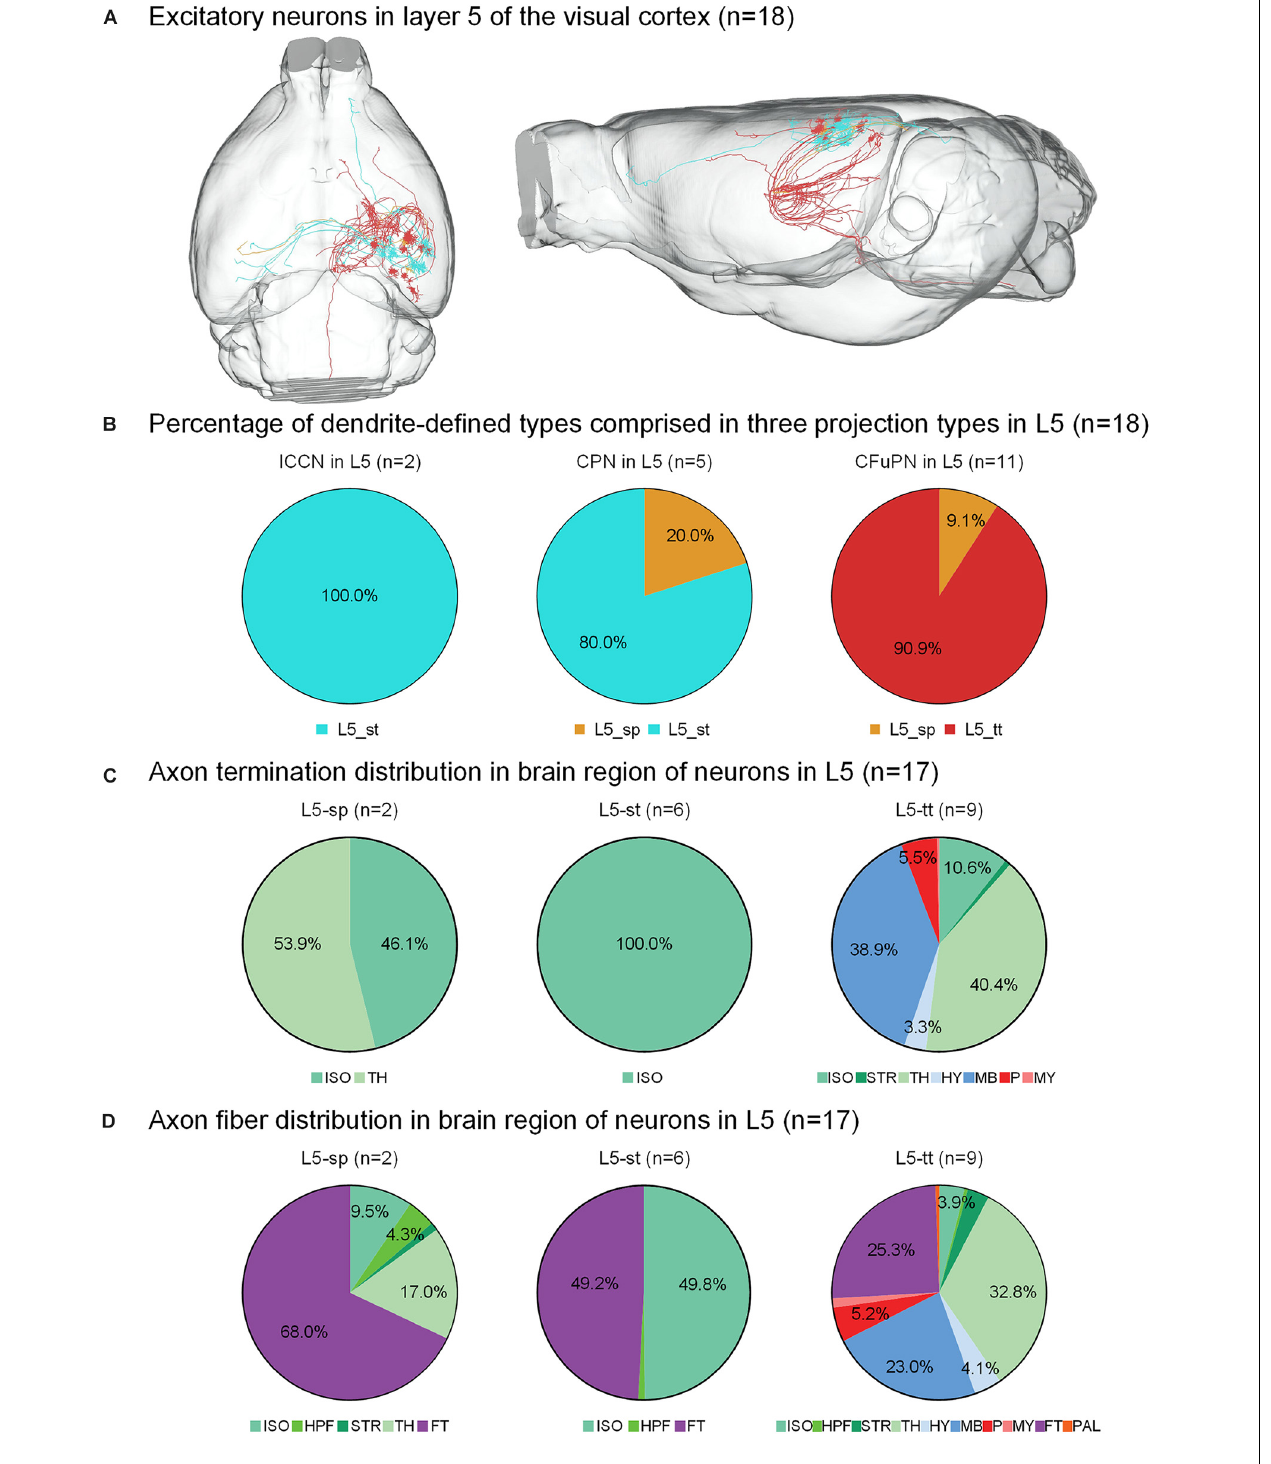
FIGURE 3 | Axonal classification and projection patterns of 18 excitatory neurons in layer 5. (A) The 18 neurons in L5 with their complete morphologies are shown in the mouse brain. (B) The percentage of dendrite-defined types comprises the ipsilateral circuit connection neurons (ICCNs), the callosal projection neurons (CPNs) and the corticofugal projection neurons (CFuPNs) in L5. (C) The pie charts show the regional distribution of axonal terminals for different neuronal types in L5. (D) The pie charts show the percentage distribution of axonal length in different brain regions for the L5 neurons. For brain regions: isocortex (ISO), hippocampal formation (HPF), striatum (STR), thalamus (TH), hypothalamus (HY), midbrain (MB), pons (P), medulla (MY), fiber tracts (FT), and pallidum (PAL).